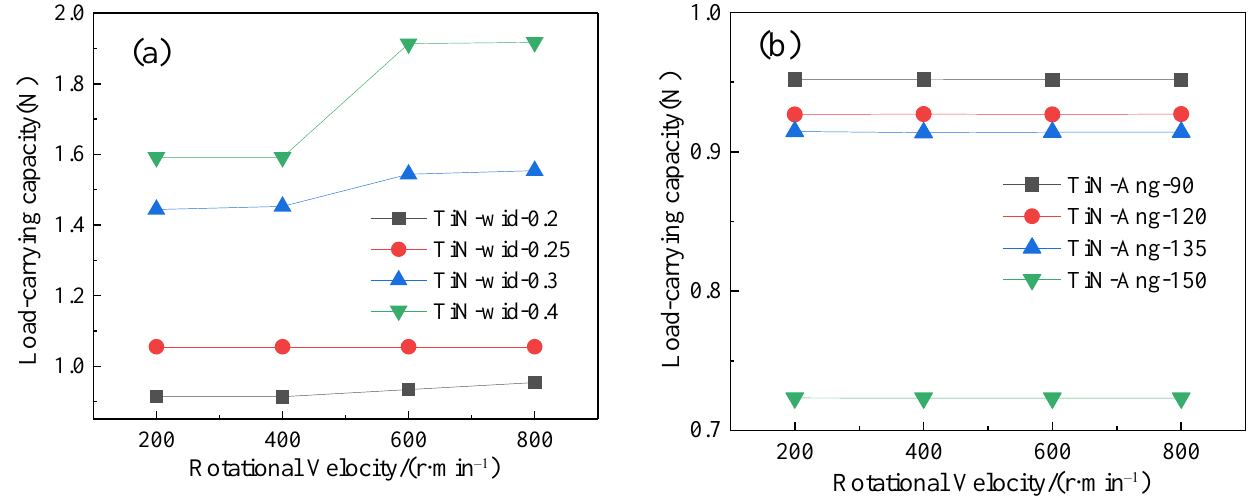
Figure 8. Load-carrying capacities for ( a ) different groove widths and ( b ) different groove angles with rotation speeds.